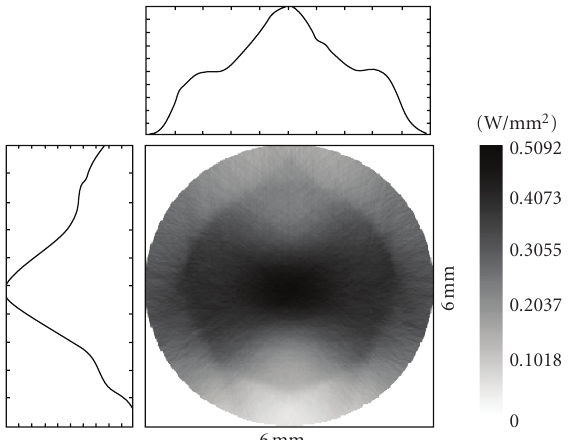
Figure 5: Gray-scale absorption distribution for the 6mm diameter Nd:YAG rod within the truncated cavity (Vertical unit in W/mm 2 ).